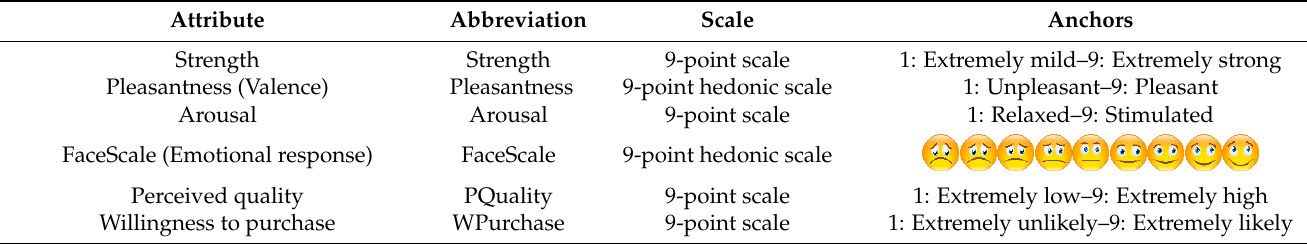
Table 1. Attributes assessed for acceptability of the coffee pod label samples.